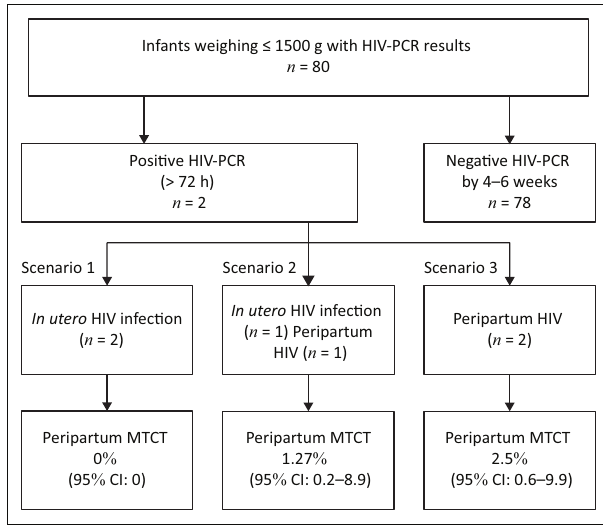
FIGURE 2: The safety of ‘raw’ mother’s own milk in human immunodeficiency virus-exposed very low birth weight infants.